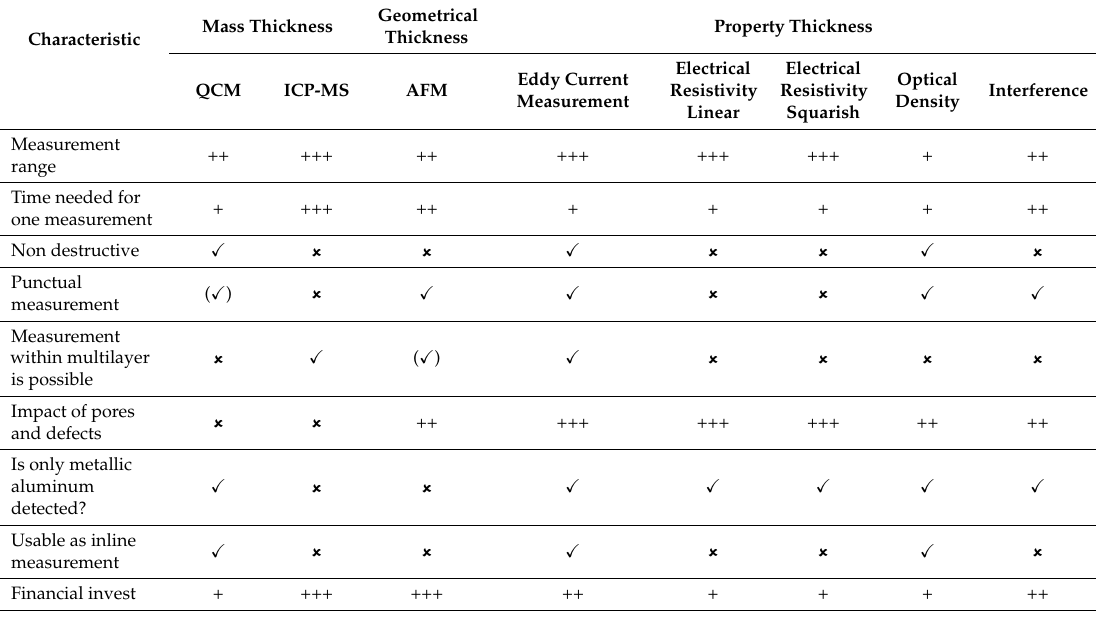
Table 1. Overview over methods.